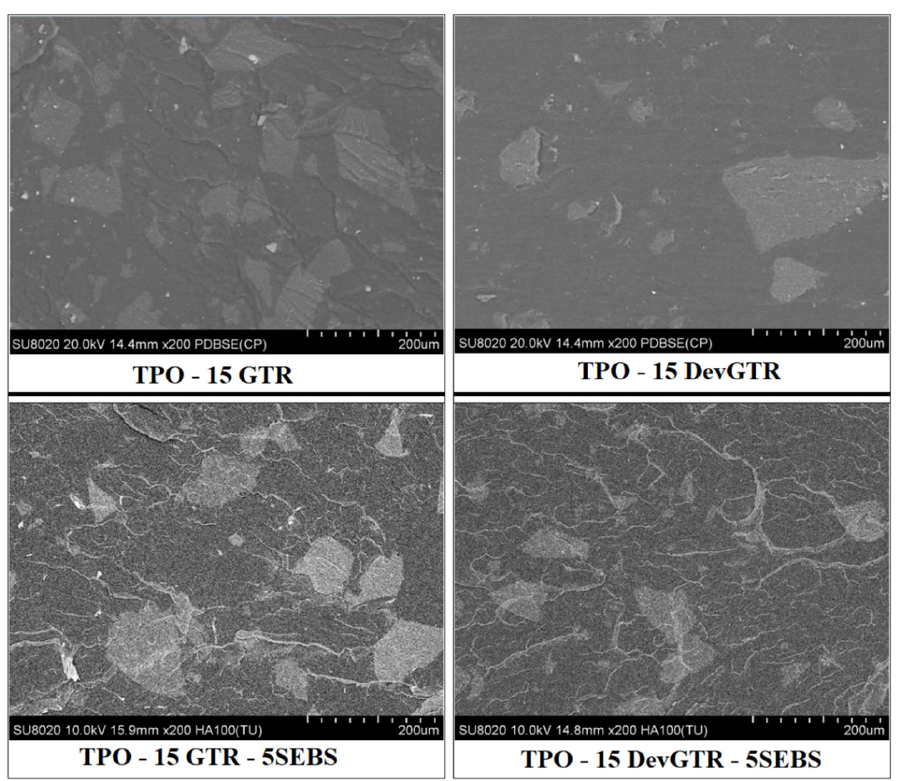
Figure 10. SEM micrographs of TPO containing 15 wt.% GTR or DevGTR, with or without the incorporation of 5 wt.% SEBS.